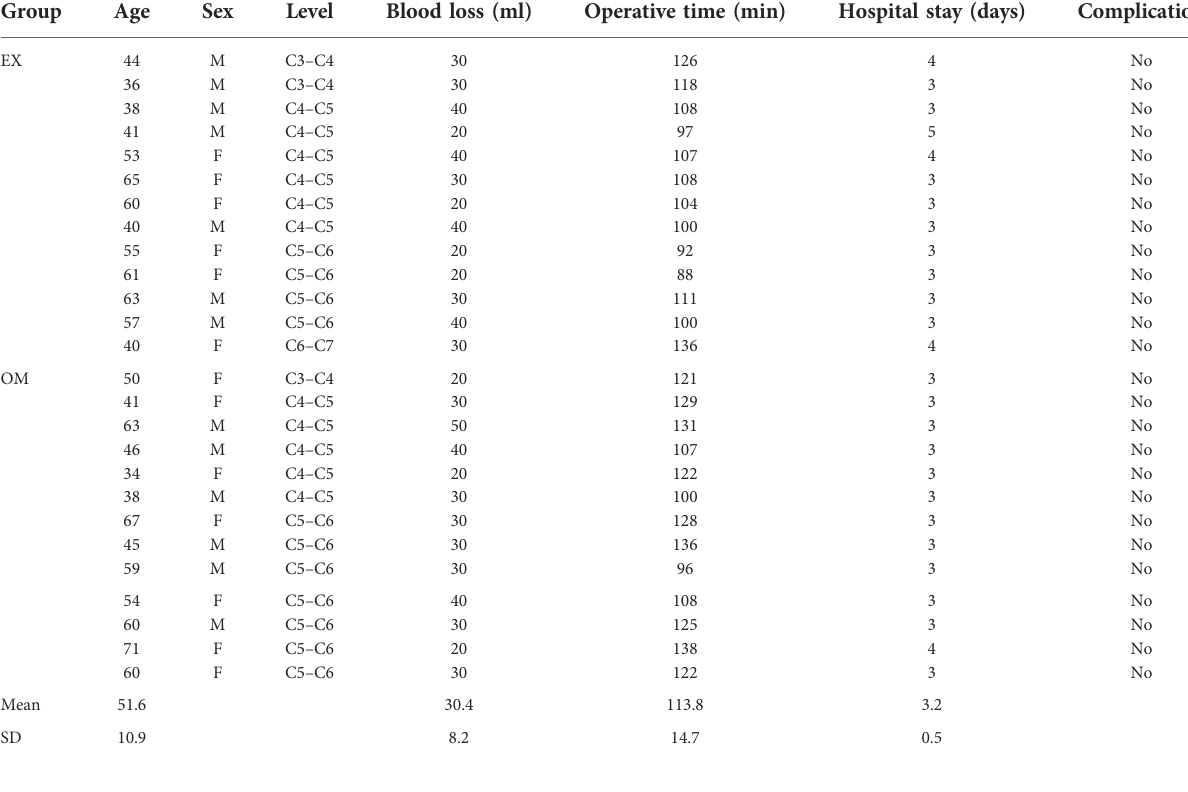
TABLE 1 Showing the patient demographics, diagnosis, and operative